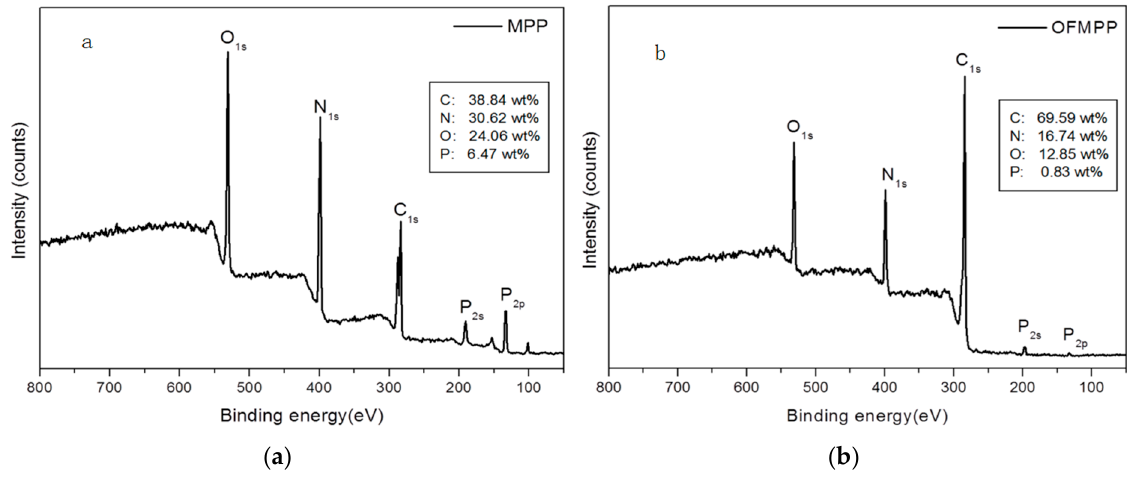
Figure 2. XPS spectra of: ( a ) MPP; and ( b ) OFMPP.